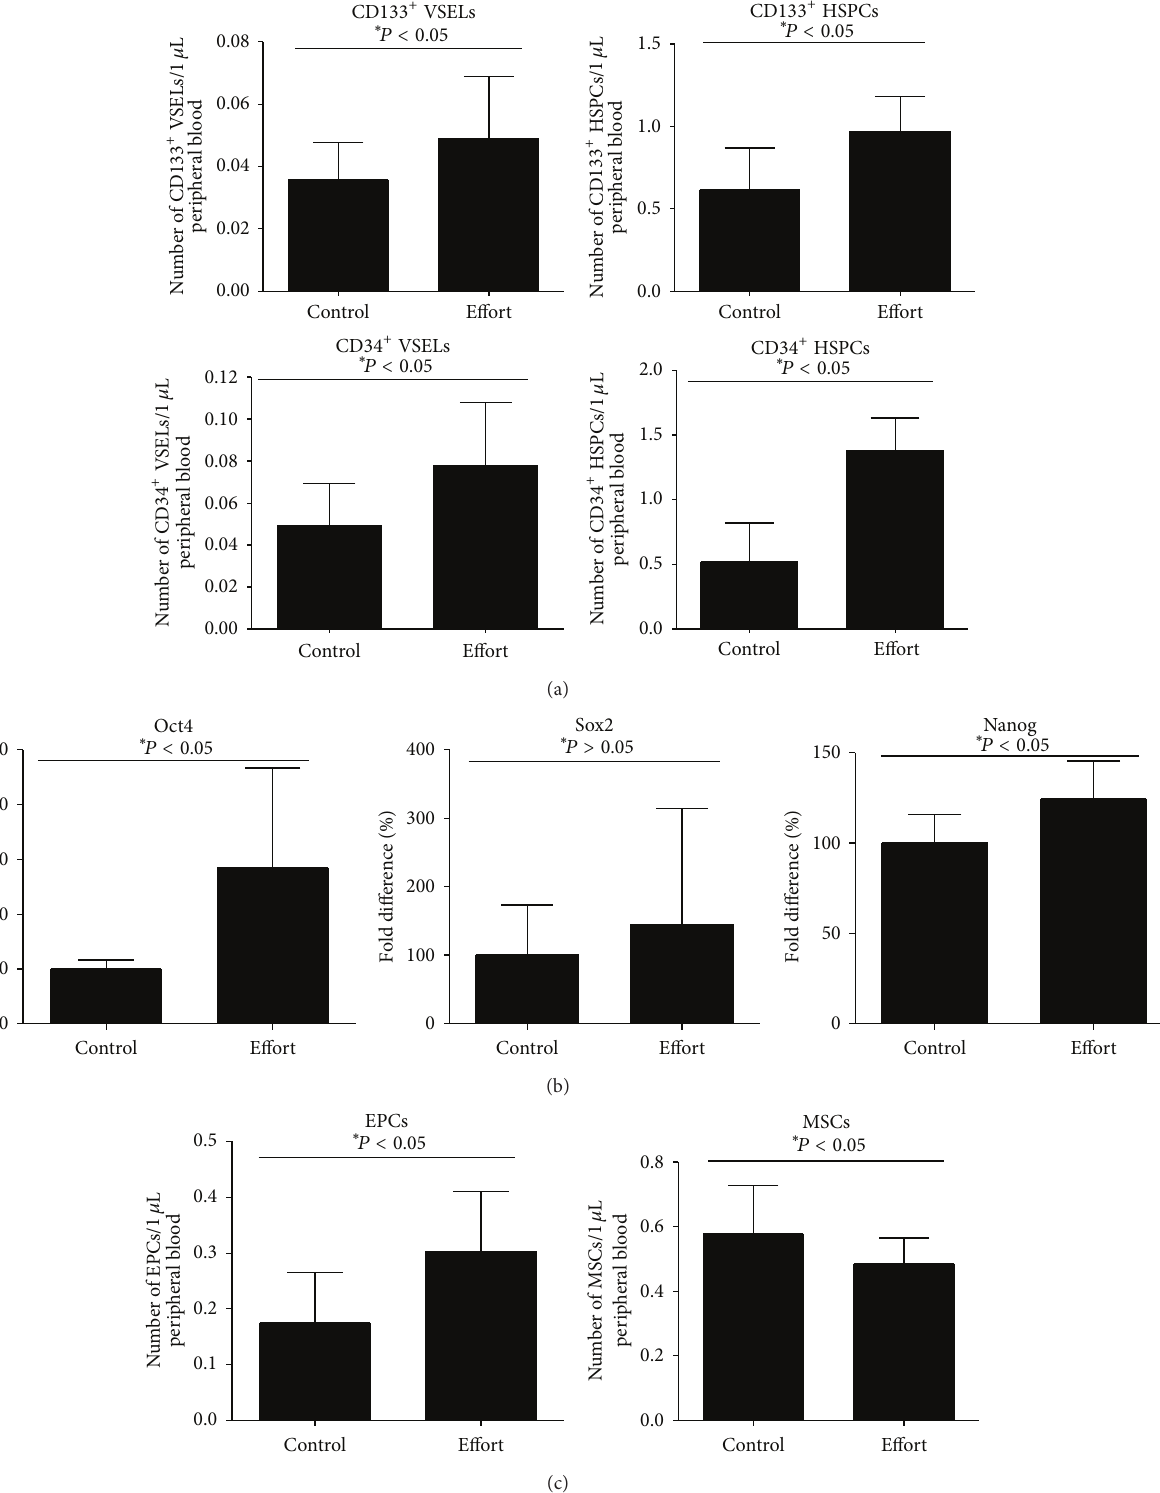
Figure 4: Effect of exercise on stem cell mobilization in healthy young volunteers. (a) The number of CD133 + and CD34 + VSELs (left) and CD133 + and CD34 + HSPCs (right) circulating in PB in young athletes after not exercising (control) or after running exercise (effort). (b) Quantitative real-time PCR changes in expression of Oct4, Sox2, and Nanog in PB mononuclear cells after running exercise (effort) compared with nonexercising subjects (control). Changes are shown compared with values detected in control volunteers (defined as 100%). (c) The number of EPCs (left panel) and MSCs (right panel) circulating in PB in young athletes after not exercising (control) or after running exercise (effort) ( 𝑛 = 6